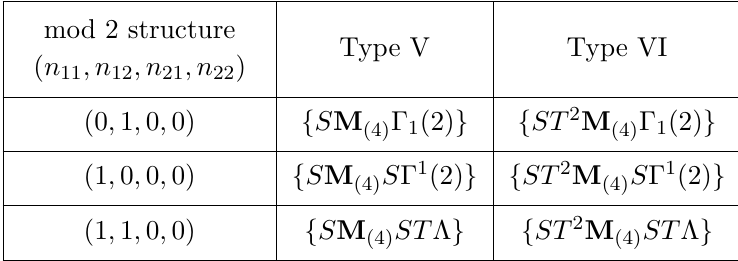
Table 13 . Classifiction of Types V and VI for D = 4